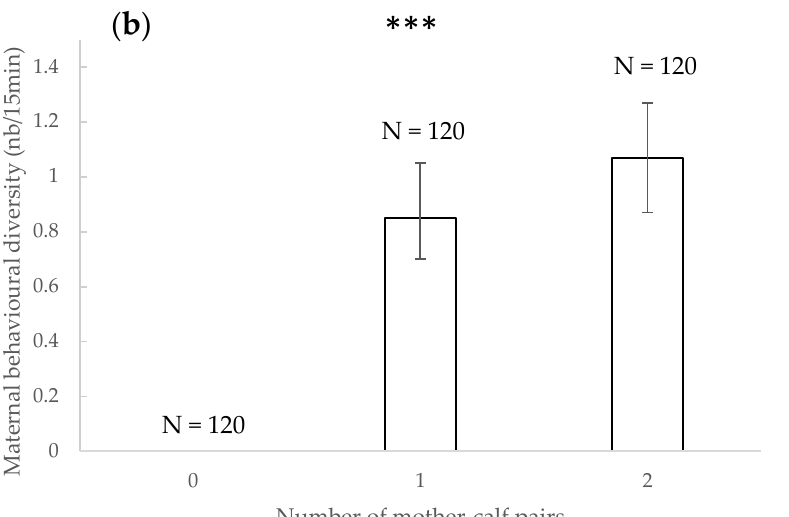
Figure 7. Mean of maternal behavioural diversity and 95% confidence intervals according to the number of individuals present ( a ) and number of mother–calf pairs present ( b ). ***: p < 0.001 (Wald chi-squared test). N: number of observations.